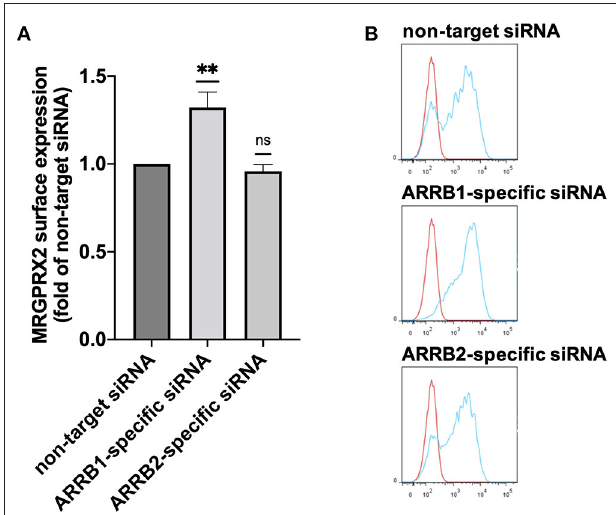
FIGURE 2 | Knockdown of β -arrestin-1 promotes MRGPRX2 expression. Skin MCs were incubated with non-target siRNA, ARRB1-selective or ARRB2-selective siRNA for 48h, MRGPRX2 cell surface expression was quantified by flow cytometry. (A) Net median fluorescence intensity (MFI) = (MFI MRGPRX2–MFI isotype) upon knockdown normalized to the respective non-target control (set as 1). The data are the mean ± SEM of n = 10, ** p < 0.01, and ns, not significant. (B) Representative histograms of A. blue: MRGPRX2, red: isotype